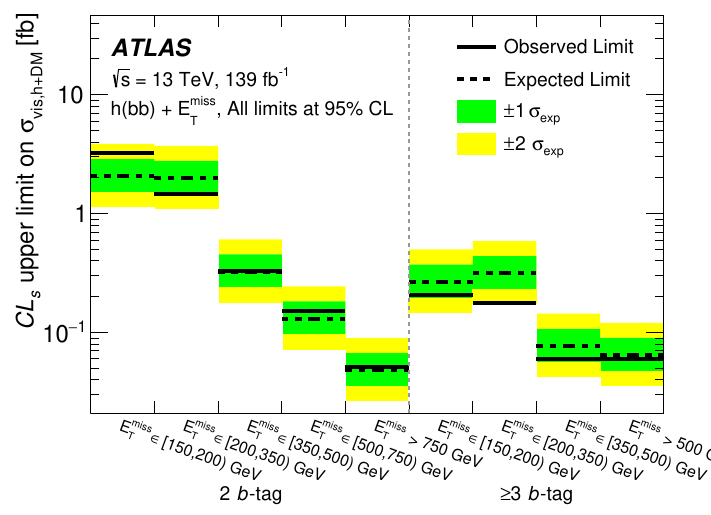
Figure 9. Model-independent upper limits on the visible cross-section σ B ( h → b ¯ b ) × A × ε in the different signal